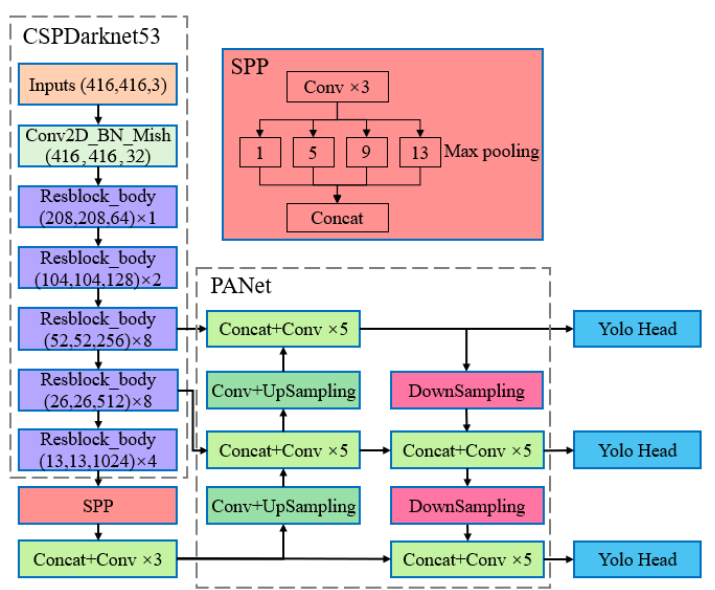
Figure 1. YOLOv4 structure diagram.